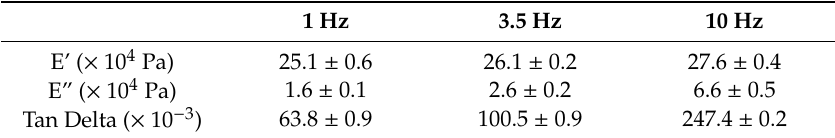
Table 5. Storage modulus (E’), loss modulus (E”), and tangent delta (Tan Delta) of AGE sponges, measured by a dynamic mechanical analyzer (DMA) at three di ff erent frequencies (1, 3.5, and 10 Hz). The data are reported as medium value ±